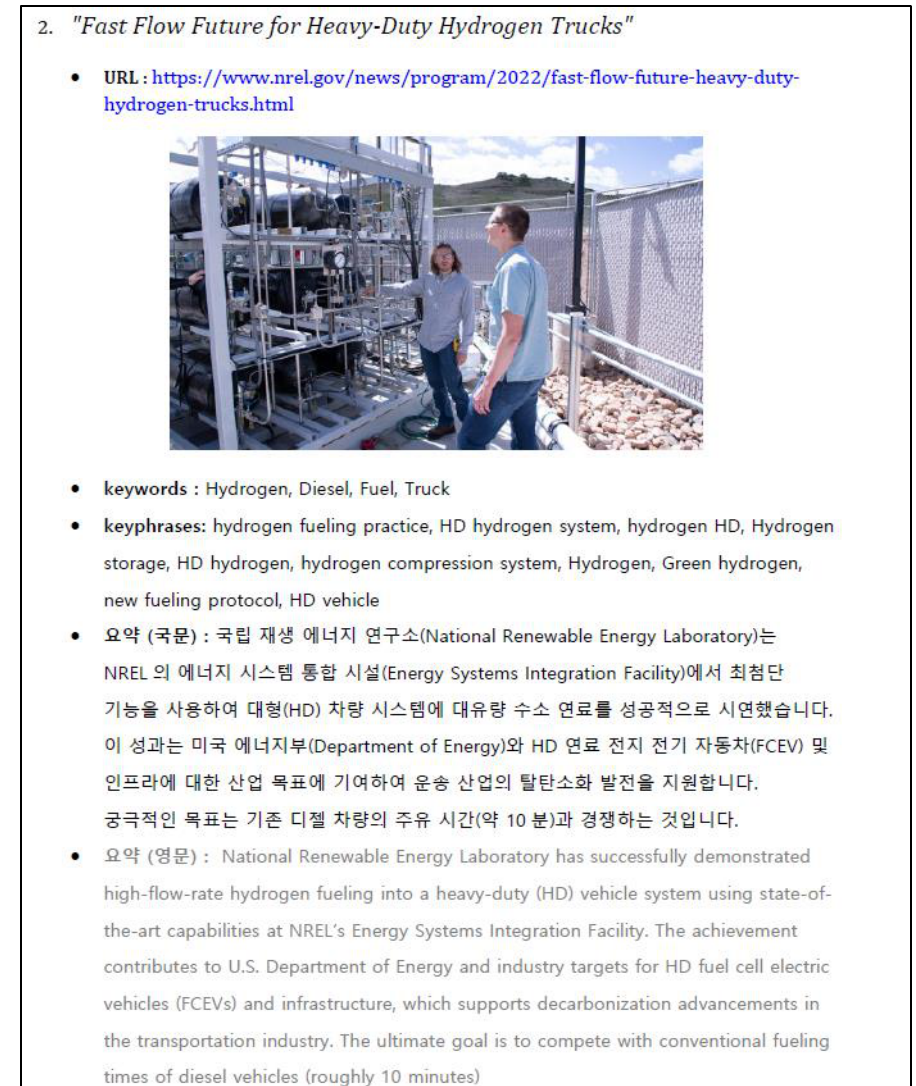
Figure 12. Screenshot of the report generated using the processes discussed in this paper. Hyper- links are applied to the URLs of the articles for readers to access the original article. The Korean parts marked with bullets stands for summary, for example, “ 요약 ( 국문 )” stands for “summary marked with bullets stands for summary, for example, “ 요 약 ( 국ᄆ ᅮ ᆫ )” stands for “summary (in (in Korean)” where “” for “summary (in English)”. Korean)” where “” for “summary (in